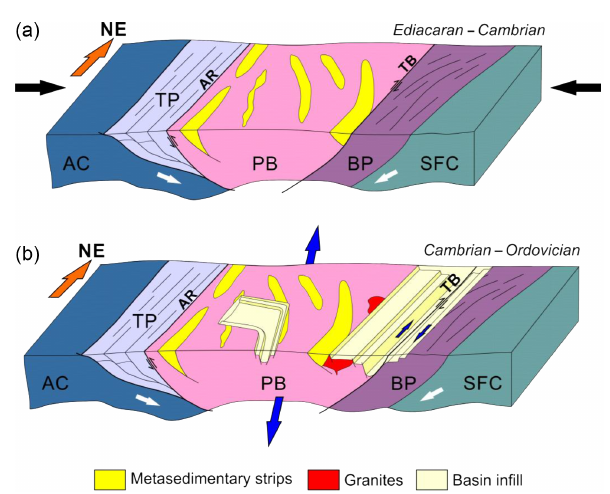
Figure 15. Schematic reconstruction for the Neoproterozoic–early Paleozoic, showing the collision of the Amazon–West African block between the Araguaia and Transbrasiliano shear zones (a) and sub- sequent post-orogenic rifting (b) . Arrows indicate Brasiliano col- lisional (black) and post-orogenic extensional (blue) stresses.